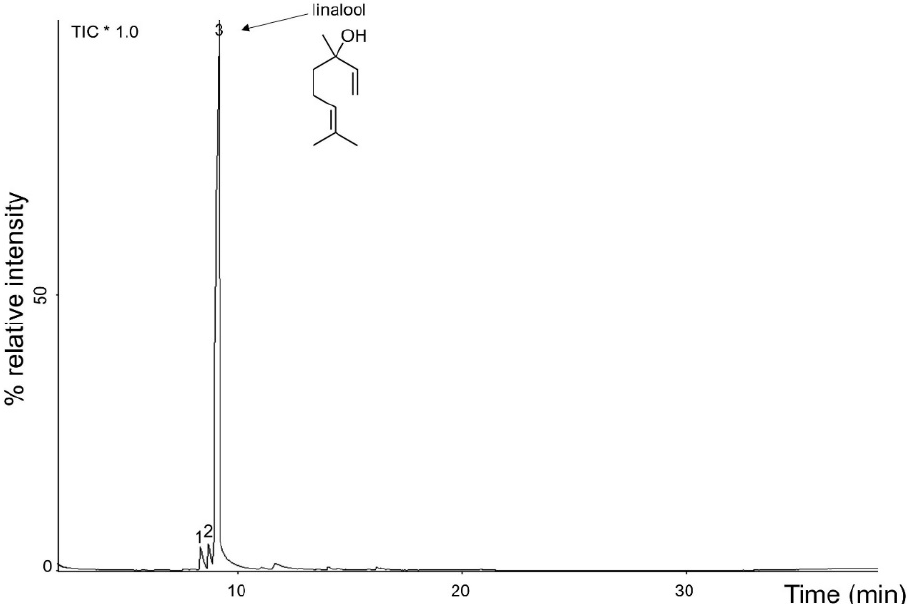
Figure 2. Chromatogram of Aniba rosaeodora essential oil. * TIC: total ion chromatogram. Table 1. Chemical composition of Aniba rosaeodora essential oil.